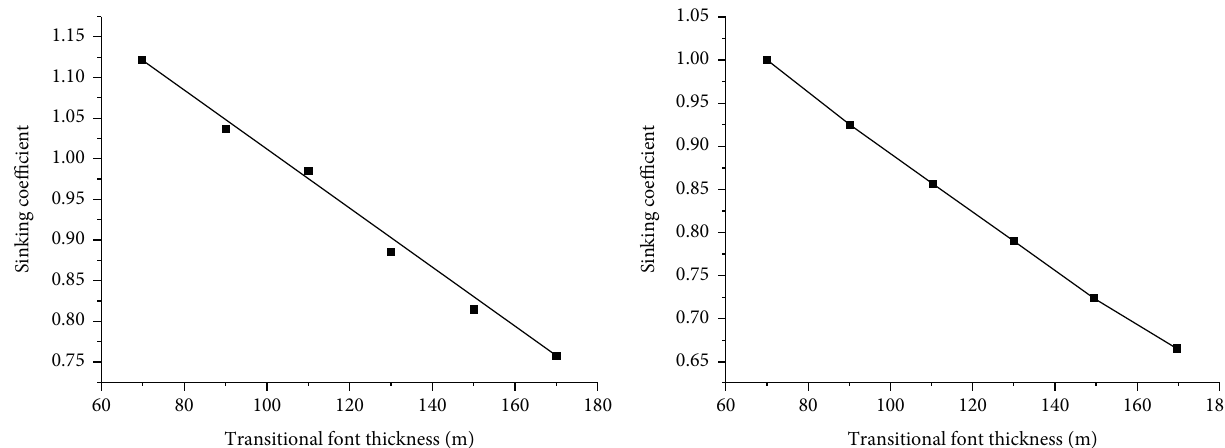
Figure 11: Variation of sinking coe ffi cient of di ff erent transitional font thickness.